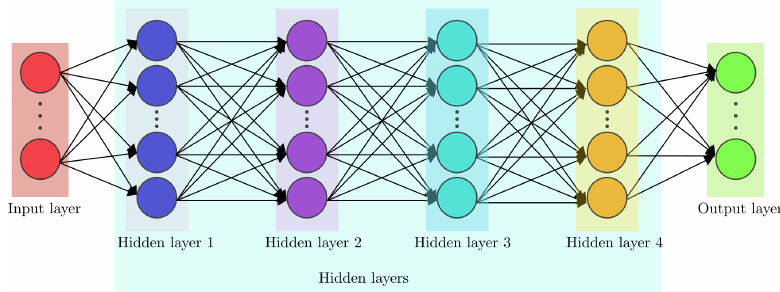
Figure 5. Schematics of the artificial neural network with four hidden